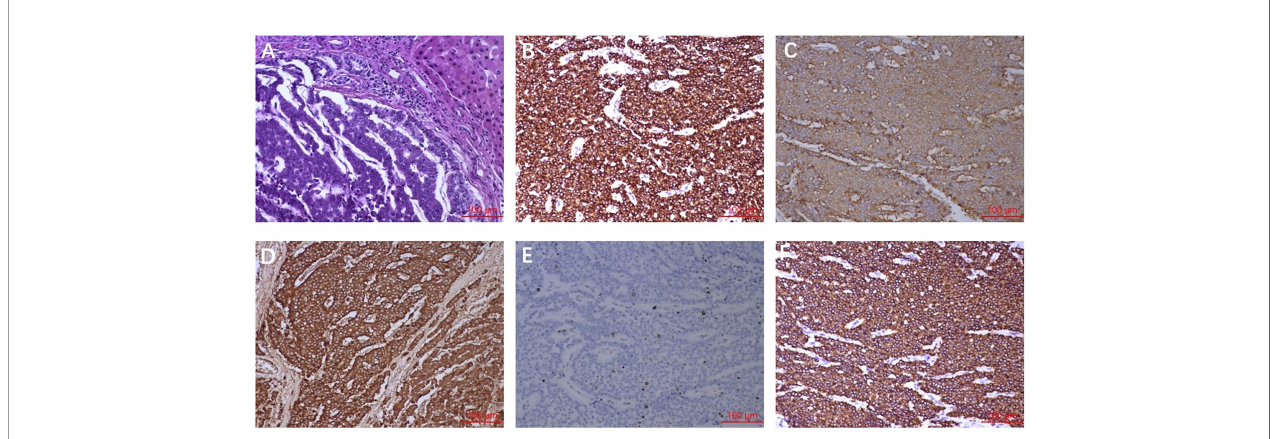
FIGURE 2 | Pathological fi ndings. (A) HE staining showed the tumour cells were arranged in nest and mass cord shape, and the cells were small and consistent. (B) AE1/AE3 staining showed diffuse cytoplasm was strongly positive. (C) Syno staining showed diffuse cytoplasmic positive. (D) ChrA staining showed diffuse cytoplasmic positive. (E) Ki-67 staining showed nuclear positive was about 5%. (F) CK18 staining showed diffuse cytoplasmic